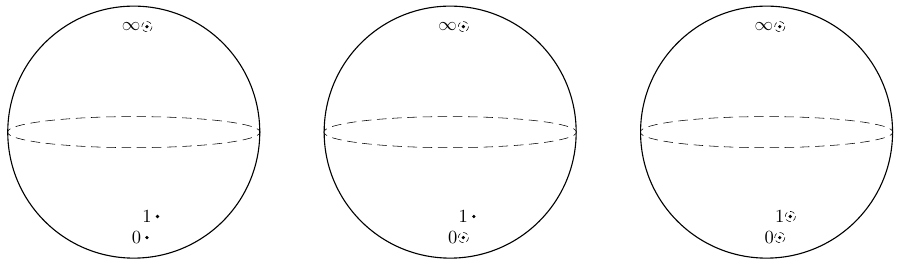
Figure 7. Building blocks for the plumbing construction. Discs with 2 punctures (left), 1 hole and 1 puncture (middle), and 2 holes (right). Here we describe them using spheres with at least one hole around , which are SL(2)-equivalent to discs with the appropriate number of holes and 1